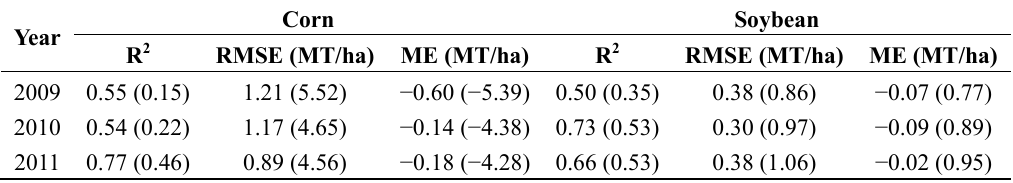
Table 3. Statistics between crop yields estimated from our approach using MODIS data and reported by the NASS for rainfed counties for each year from 2009 to 2011. For comparison, values in parentheses are statistics using the standard MOD17